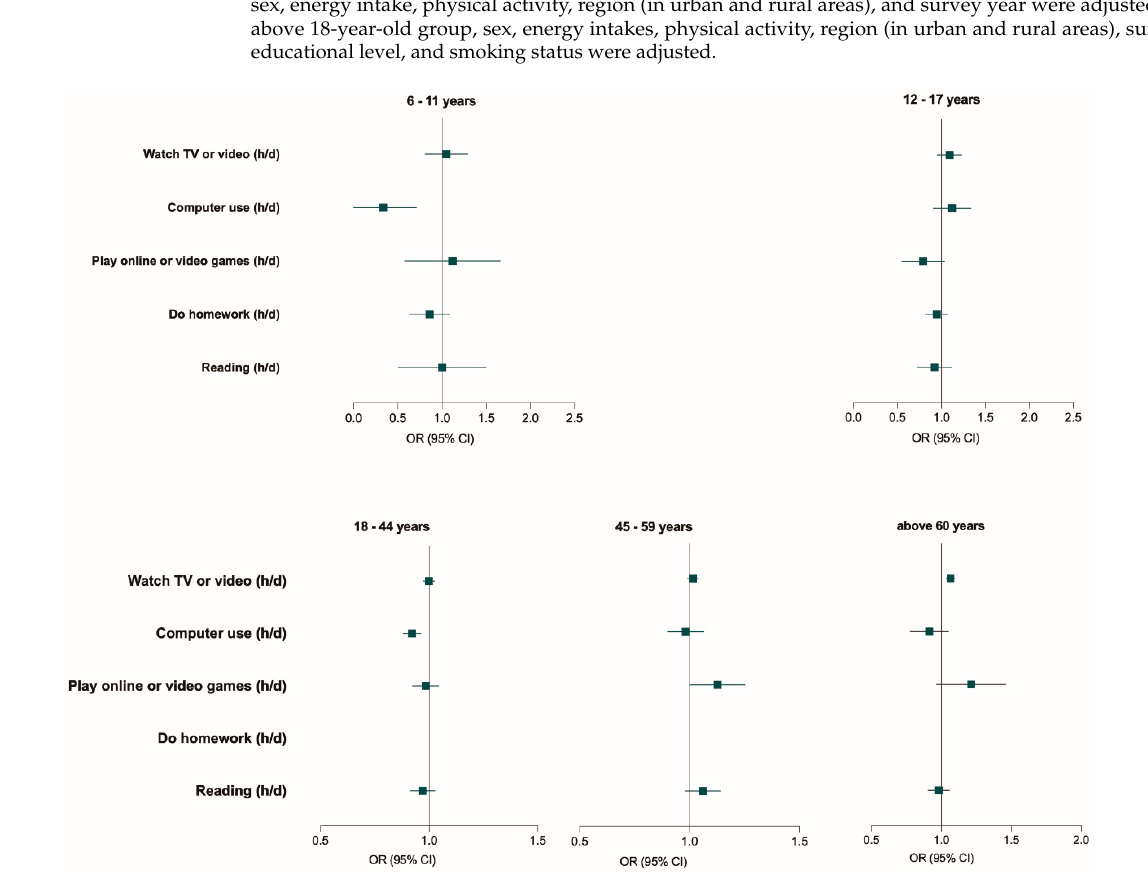
Figure 4. Association between leisure-time sedentary behaviors with excessive weight among the Chinese population, CHNS 2004-2011. Note: OR: odds ratio; CI: confidence interval; h/d: hours per day. For the 6–11- and 12–17-year-old groups, sex, energy intakes, physical activity, region (in urban and rural areas), and survey year were adjusted. For the above 18-year-old group, sex, energy intakes, physical activity, region (in urban and rural areas), survey year, educational level, and smoking status were adjusted. Table 1. Association between leisure-time sedentary behaviors and excessive weight among the Chinese population, CHNS 2004-2011.